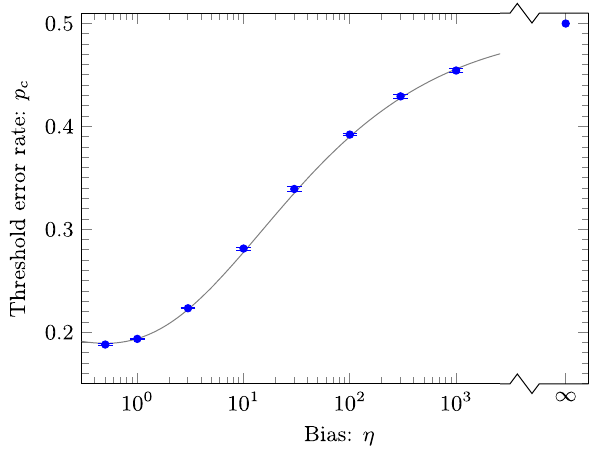
FIG. 1. Threshold error rate p as a function of bias η . Points c show threshold estimates for the surface code. Error bars indicate one standard deviation relative to the fitting procedure. The point at the smallest bias corresponds to η ¼ 0 . 5 or standard depola- rizing noise. The point at infinite bias indicates the analytically proven 50% threshold value. The gray line is the hashing bound for the associated Pauli error